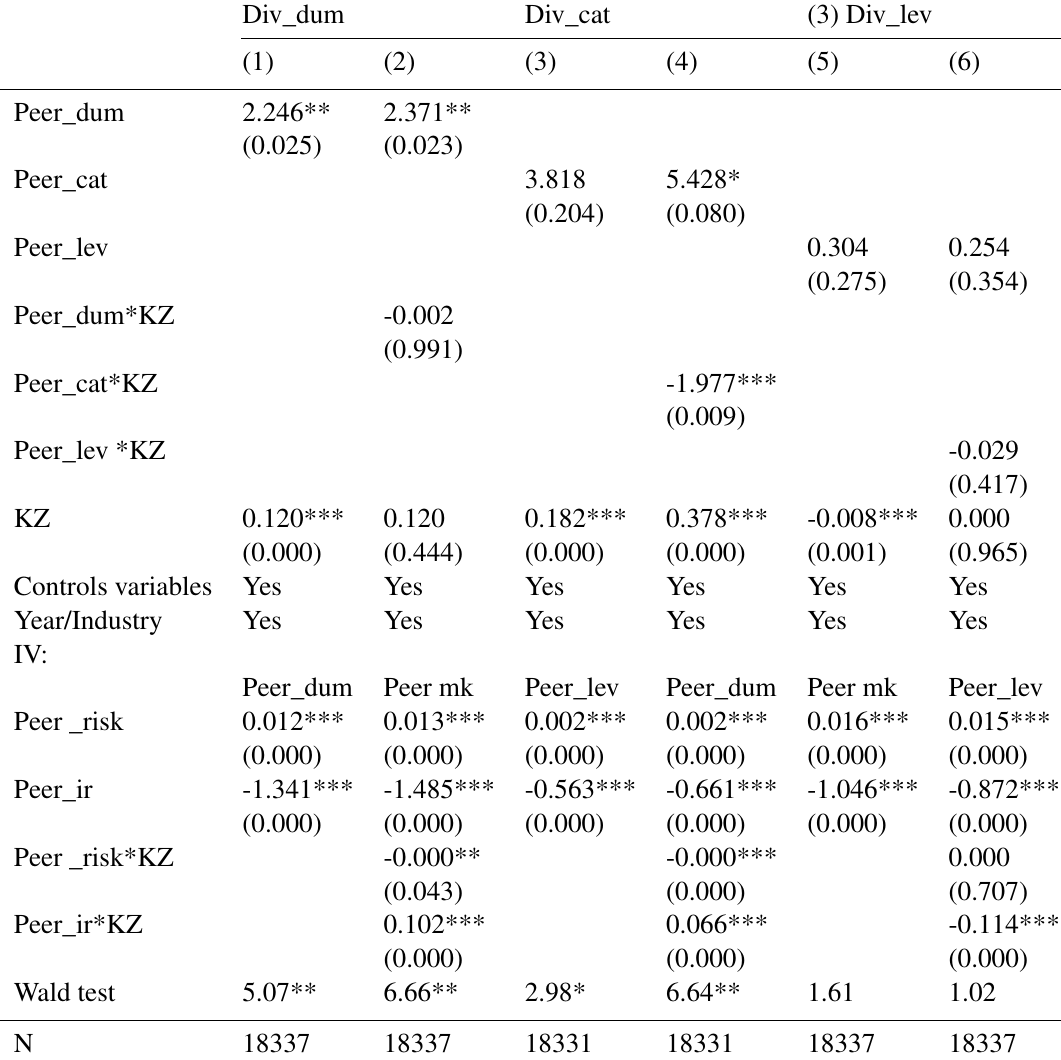
Table 5 Financial constraints, peer influence and dividend